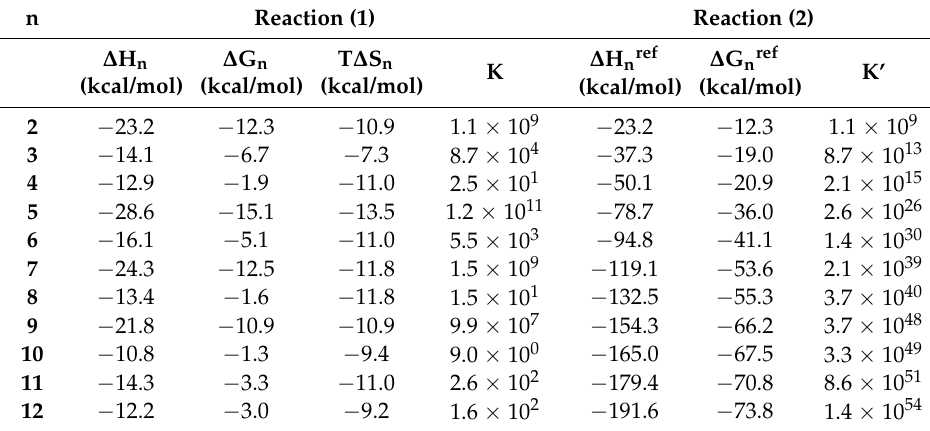
Table 2. The reaction enthalpies, Gibbs free energies, entropies and equilibrium constants for reaction (1) and (2) calculated with B3LYP-D3(BJ)/GEN/IEF-PCM//B3LYP/GEN /IEF-PCM method (for details see Figure 1 caption, BJ = Becke and Johnson